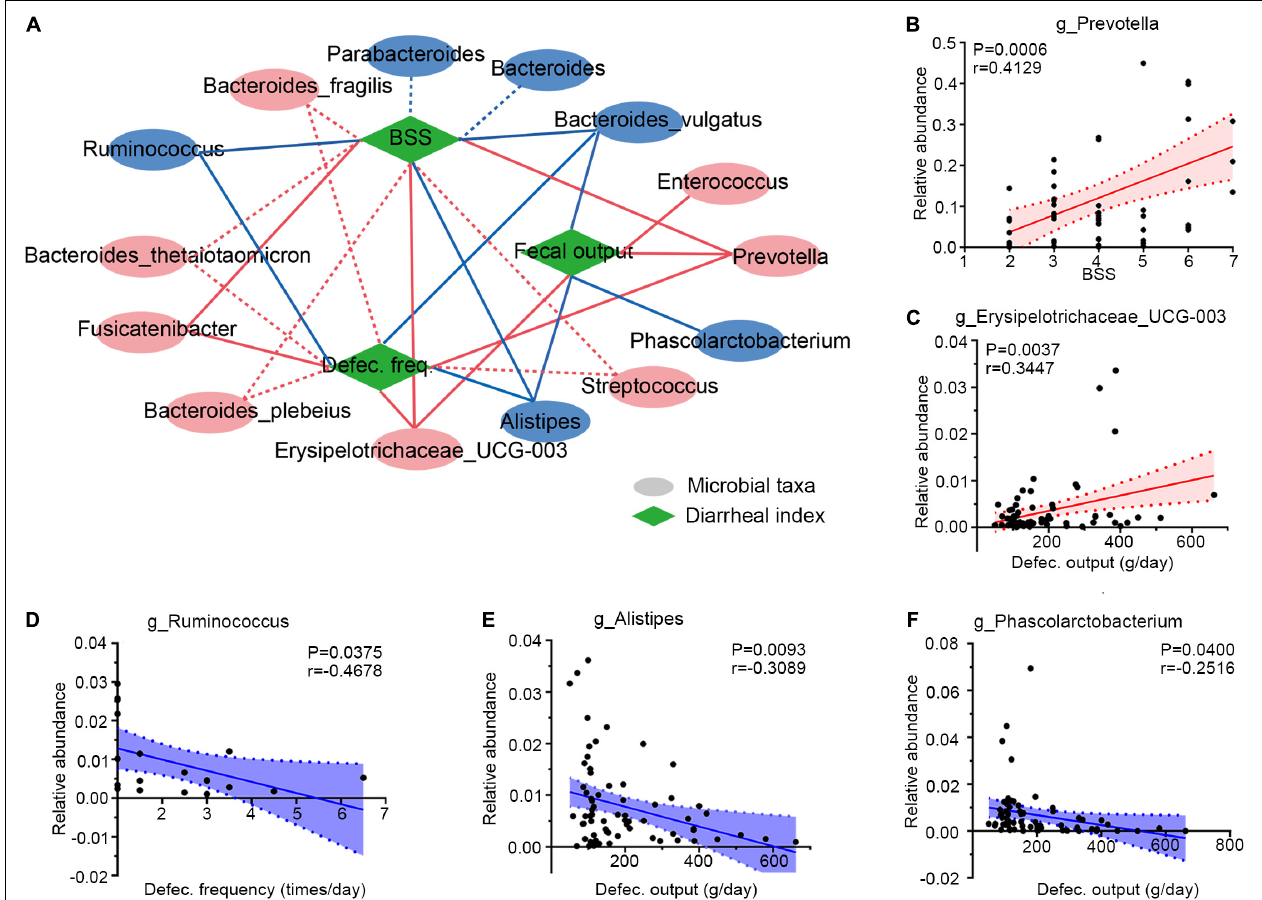
FIGURE 4 | Integrative correlation network of specific and diarrheal phenotype. (A) Correlation network displaying significant associations between altered gut microbes with diarrheal parameters. Microbes and clinical indexes were denoted by circles and rhombus; red color shows an increase (positive related) and blue shows a decrease (negative related) in diarrheal individuals. Any correlations with p > 0.05 and | r | < 0.25 were abolished; dotted and solid lines were significant and suggestive associations. (B–F) Representatives of special genera-clinical indexes linear correlations. Associations between Prevotella and BSS (B), Erysipelotrichaceae_UCG-003 and defection output (C) , Ruminococcus and defection frequency (D), Alistipes and defecation output (E) , and Phascolarctobacterium and defecation output (F) . Dotted lines show error bar, and areas between two dotted lines denote 95% confidence interval; red indicates positive correlations and blue denotes negative correlations. Single datum point was abandoned once it deviated the correlation line dramatically. BSS, Bristol stool score, defec.,